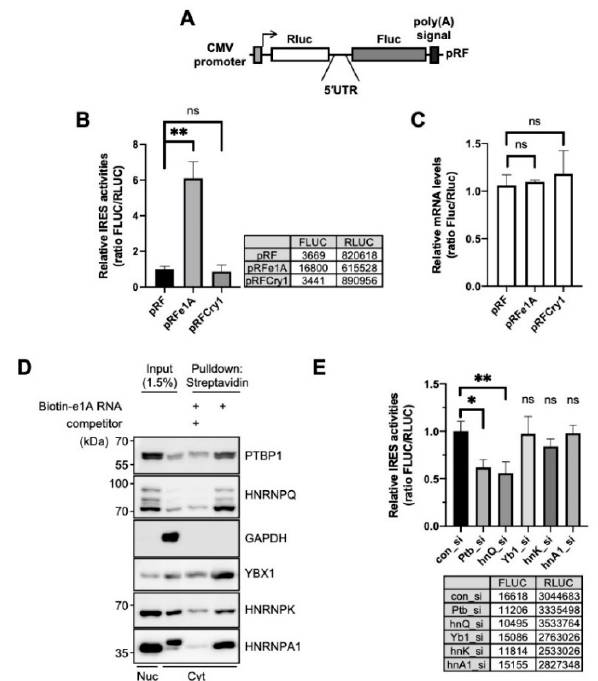
Figure 1. Polypyrimidine tract-binding protein 1 (PTBP1) is an ITAF of the Per1 5 (cid:48) -untranslated